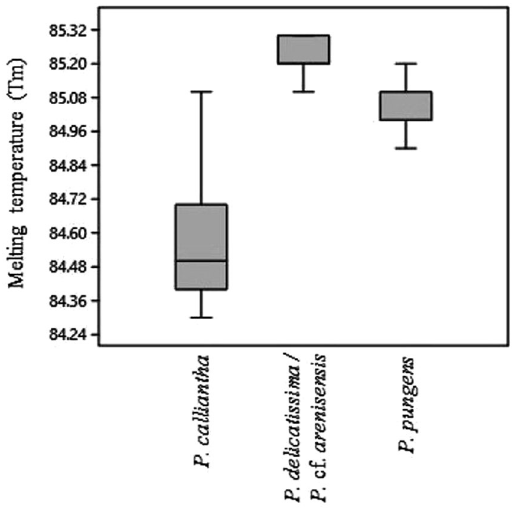
Figure 3. Box plot showing melting curve temperatures (Tm) of Pseudo-nitzschia spp. isolates collected in the NW Adriatic Sea and used in this study. The Kruskall Wallis test shows significant differences in average Tm values among species (p <